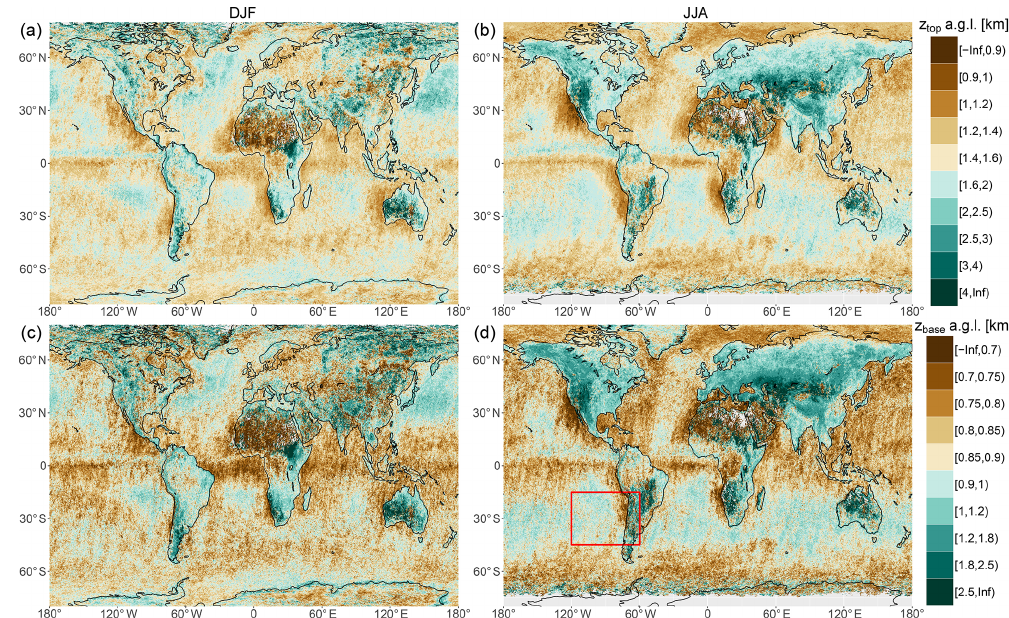
Figure 11. Global distribution of seasonal median cloud heights for a 3-year period (2007–2009). Shown are z top (a, b) , and z base (c, d) for December, January and February (a, c) and June, July and August (b, d) on a 0.25 ◦ × 0.25 ◦ latitude–longitude grid. z base and z top are above ground level (a.g.l.). z base and z top retrievals are only included in the statistic if z base is below 5000m. The red rectangle in (d) frames the region for which results over a 16-year period are presented in Fig.